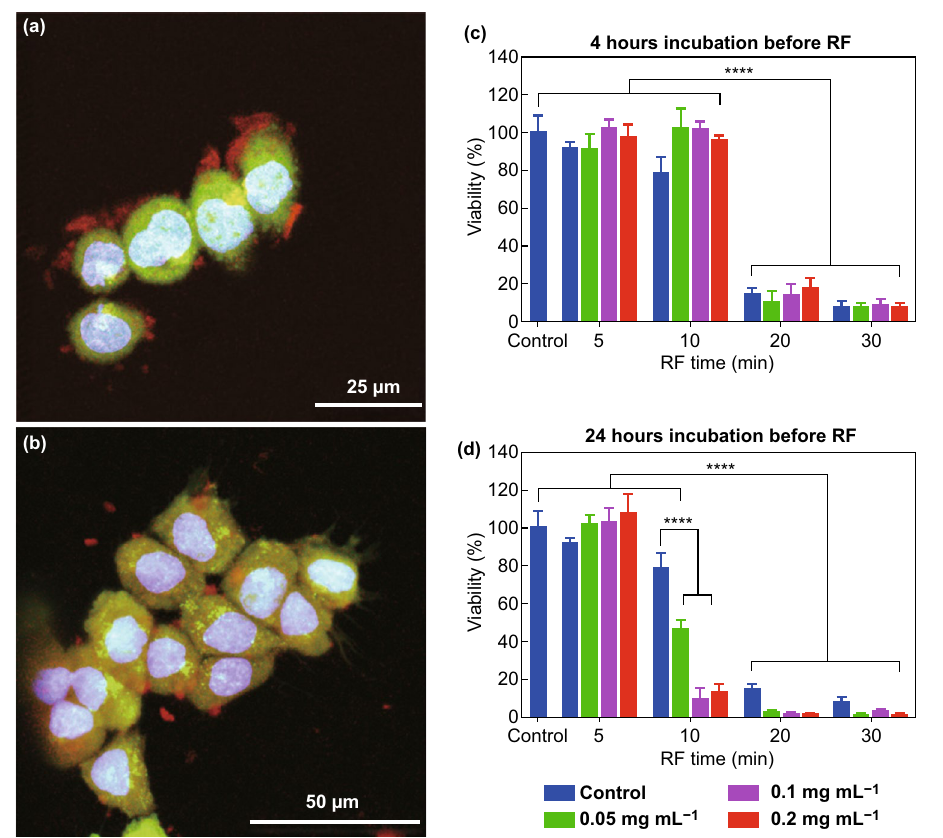
Fig. 5 a Confocal images of HepG2 cells incubated with PSi NWs 4 h and b 24 h. c HepG2 cells viability upon the incubation with different concentrations of PSi NWs for 4 h and the further RF irradiation. d HepG2 cells viability upon the incubation with different concentrations of PSi NWs for 24 h and the further RF irradiation. Results are shown as mean ± SD **** p < 0.0001. Adapted with permission from Ref.